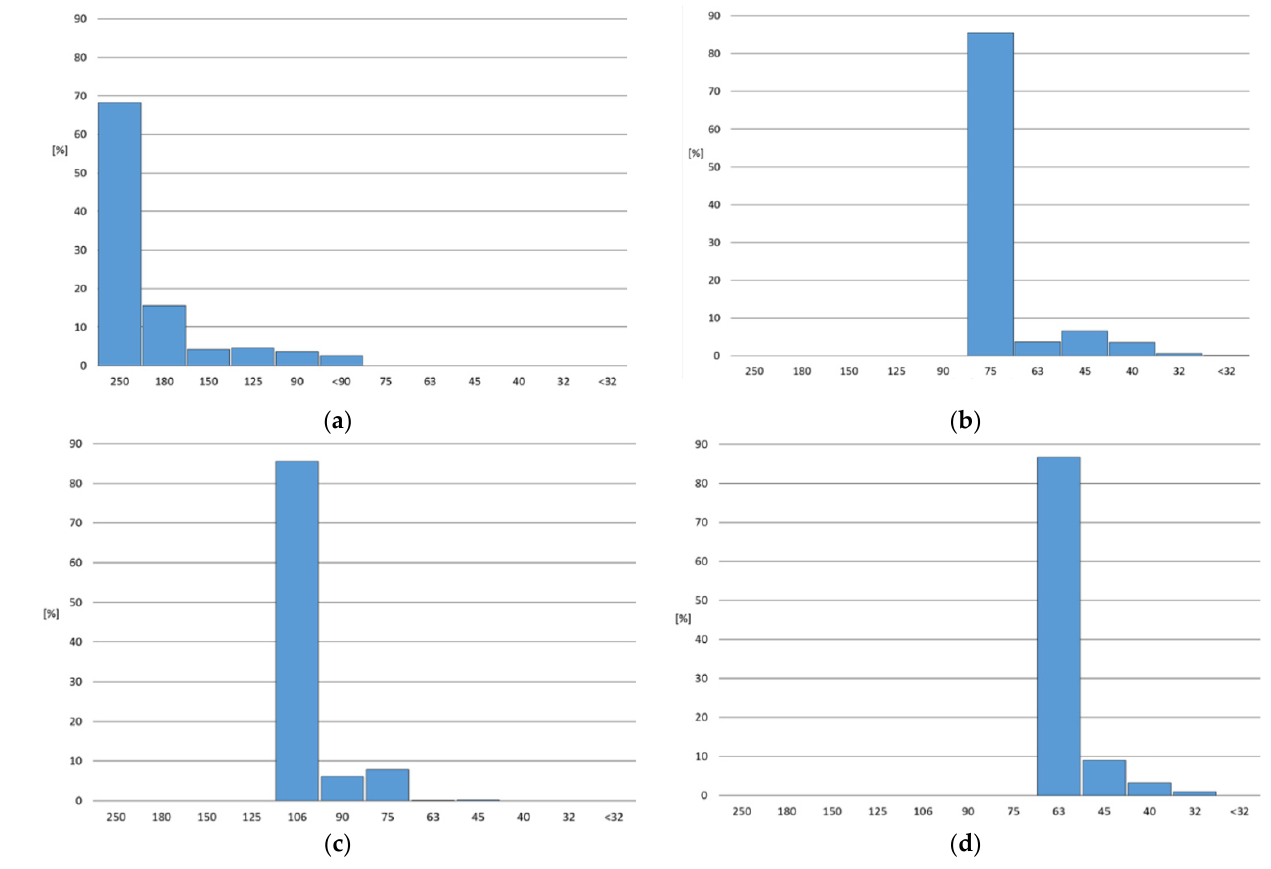
Figure 5. Presentation of the number of fractions of spruce wood dust samples. Legend: ( a ) WD_Saw; ( b ) WD_ExtrD; ( c ) WD_Briq; ( d ) WD_Grin. The clarity of the particle number shows the largest proportion of the saw sample.